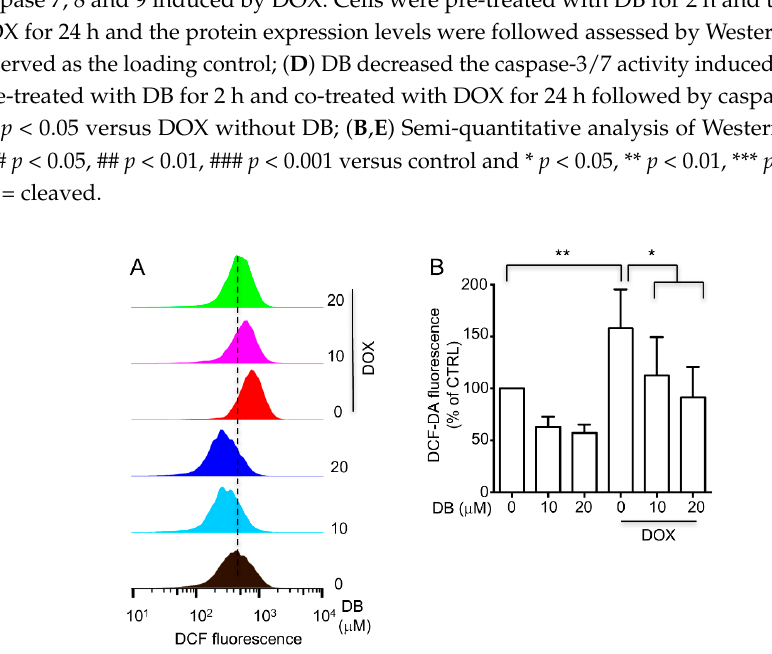
Figure 5. ( A ) The inhibitory effects of DB on intracellular ROS generation induced by DOX. H9c2 cells were pre-treated without or with DB for 2 h, followed by incubation with 1 μ M DOX for another 24 h. ROS generation was assayed by DCFH 2 -DA oxidation-based fluorescence using a flow cytometry. ( B ) ROS levels are expressed in terms of relative intensity of cell fluorescence. * p < 0.05, ** p < 0.01, compared with DOX alone treated group.